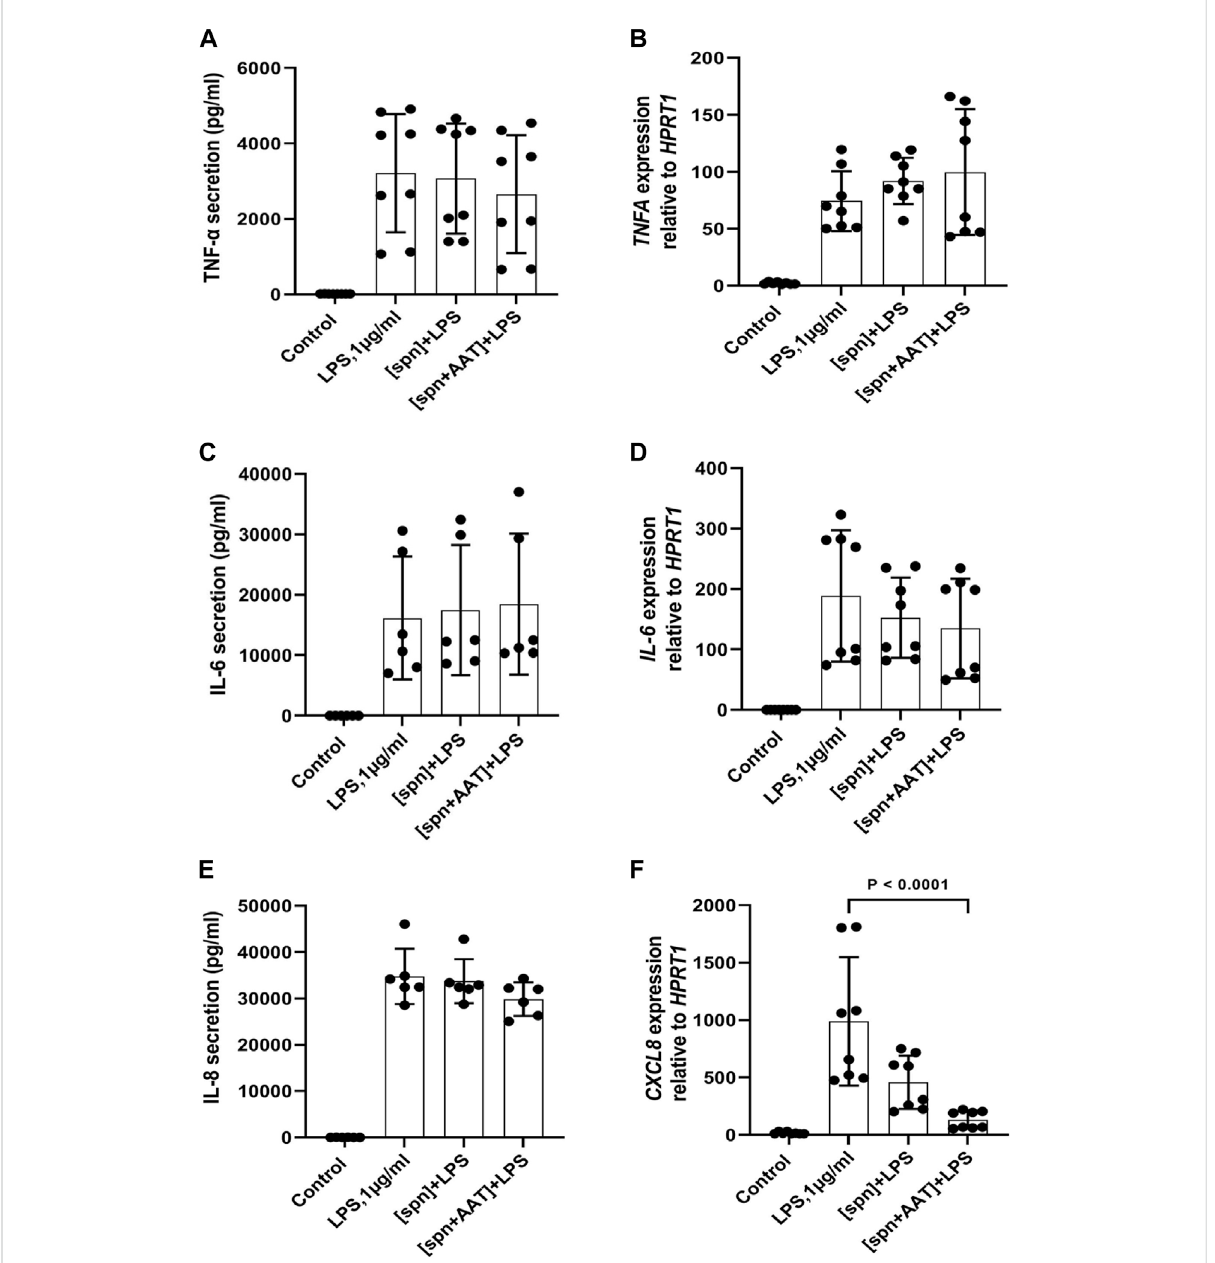
FIGURE 3 Effects of conditioned media from autologous PBMCs pre-treated with AAT (Zemaira ® ) on LPS-induced release and expression of TNF- α , IL-6, and IL-8 in total PBMCs. LPS-induced TNF- α , IL-6 and IL-8 secretion [ (A,C,E) respectively] and expression [ (B,D,F) respectively] within 6 h in total PBMCs cultured in supernatants from autologous PBMCs pre-treated for 30 min with PBS [spn] or with AAT (Zemaira ® , 4 mg/ml), [spn + AAT]. Each bar represents the mean (SD) from four or three independent donor experiments, with two repeats for each. p -value indicates signi fi cance between LPS and [spn +